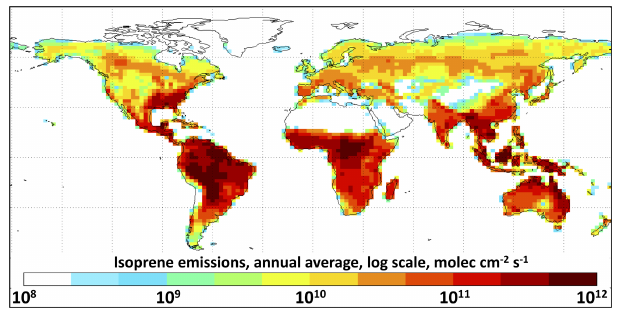
Figure 2. Annually averaged MEGAN v2.1 isoprene emissions for July 2014–June 2015 as implemented in GEOS-Chem at 2 ◦ × 2 . 5 ◦ horizontal